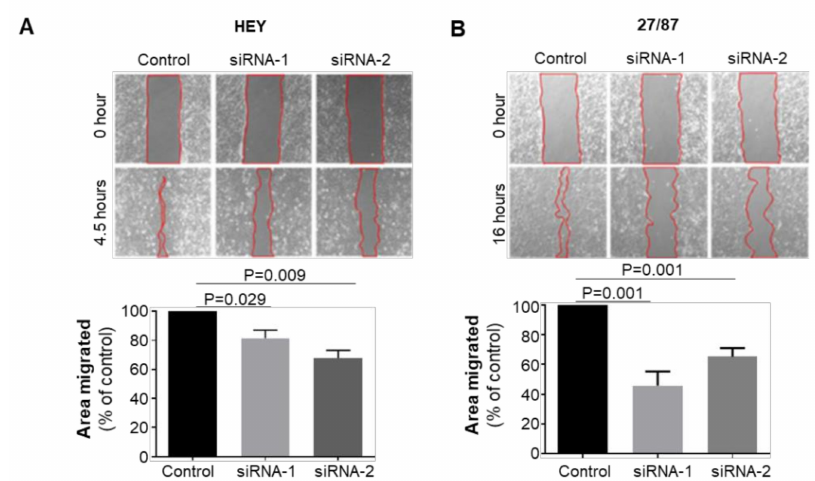
Figure 2. ABCA1 supported the migration of epithelial ovarian cancer cells. Wound healing assays performed on ( A ) HEY and ( B ) 27/87 EOC cells with or without ABCA1 suppression. Changes in relative wound size was expressed as a percentage of control. n = 3 ( A ), n = 4 ( B ). Results represent the mean ± SD. p -Values were derived from one-sample t -tests.